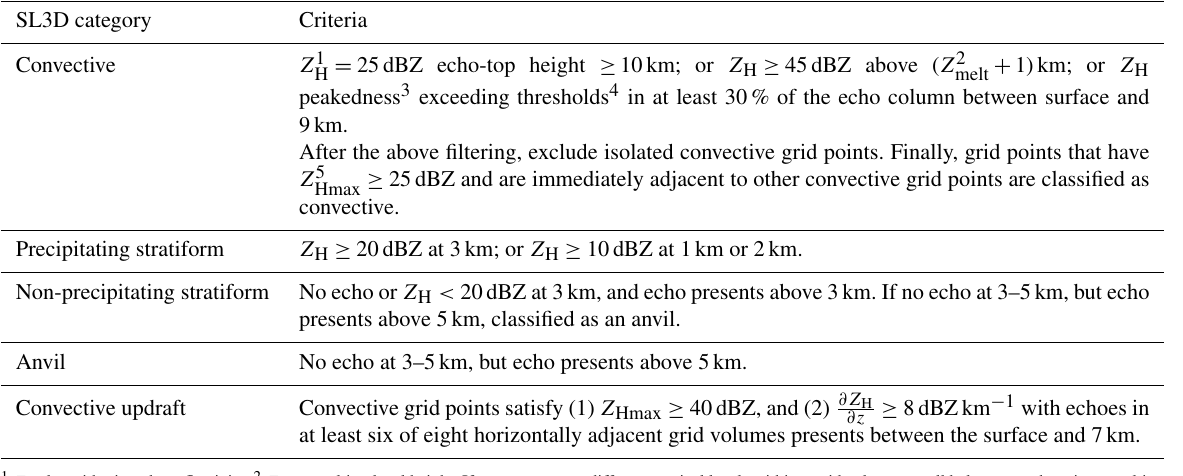
Table A2. The classification criteria of the Storm Labeling in Three Dimensions (SL3D) algorithm in this study. SL3D category Criteria Convective